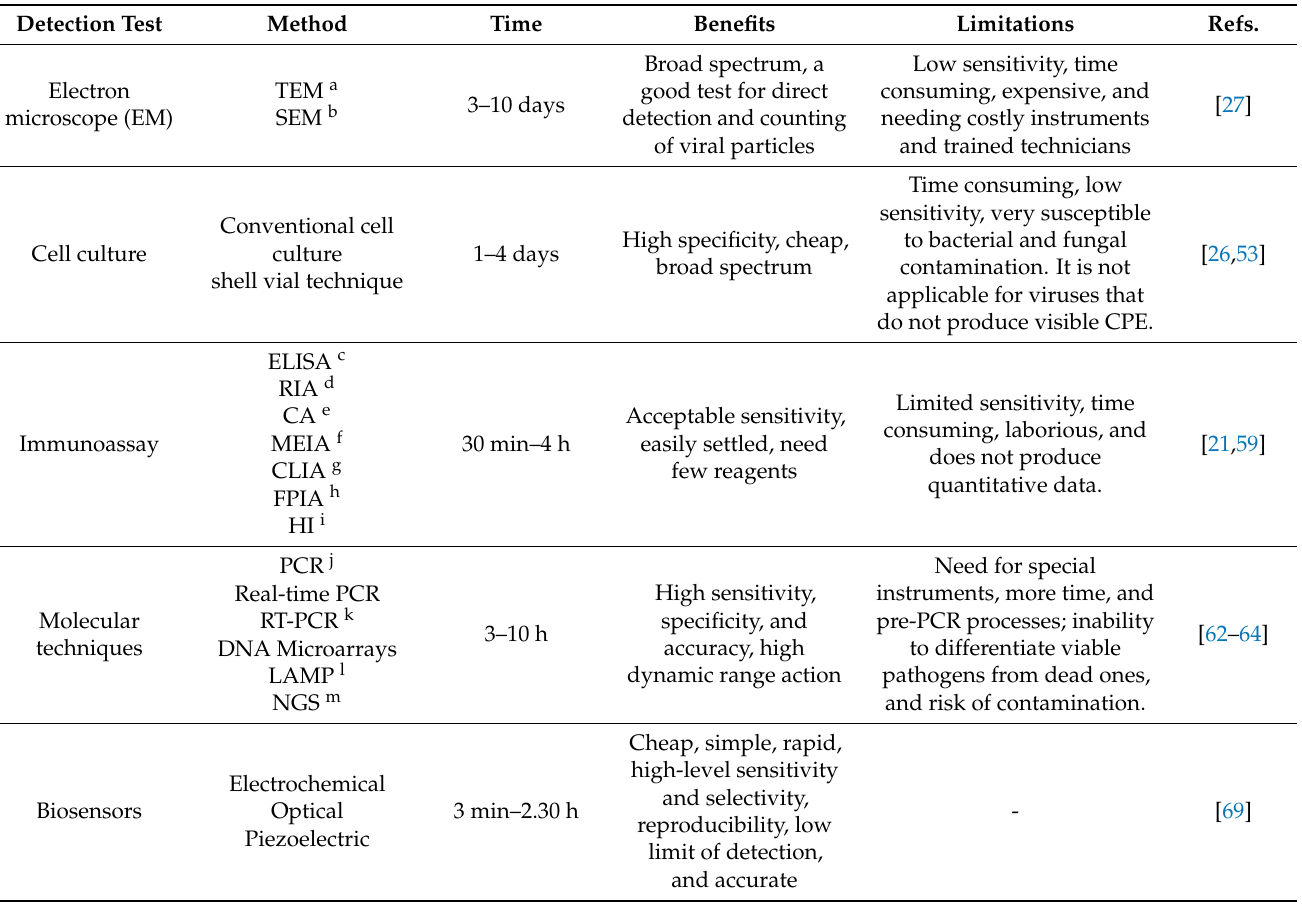
Table 1. Summary of routine and newly emerged diagnostic approaches for gastroenteritis viruses. Detection Test